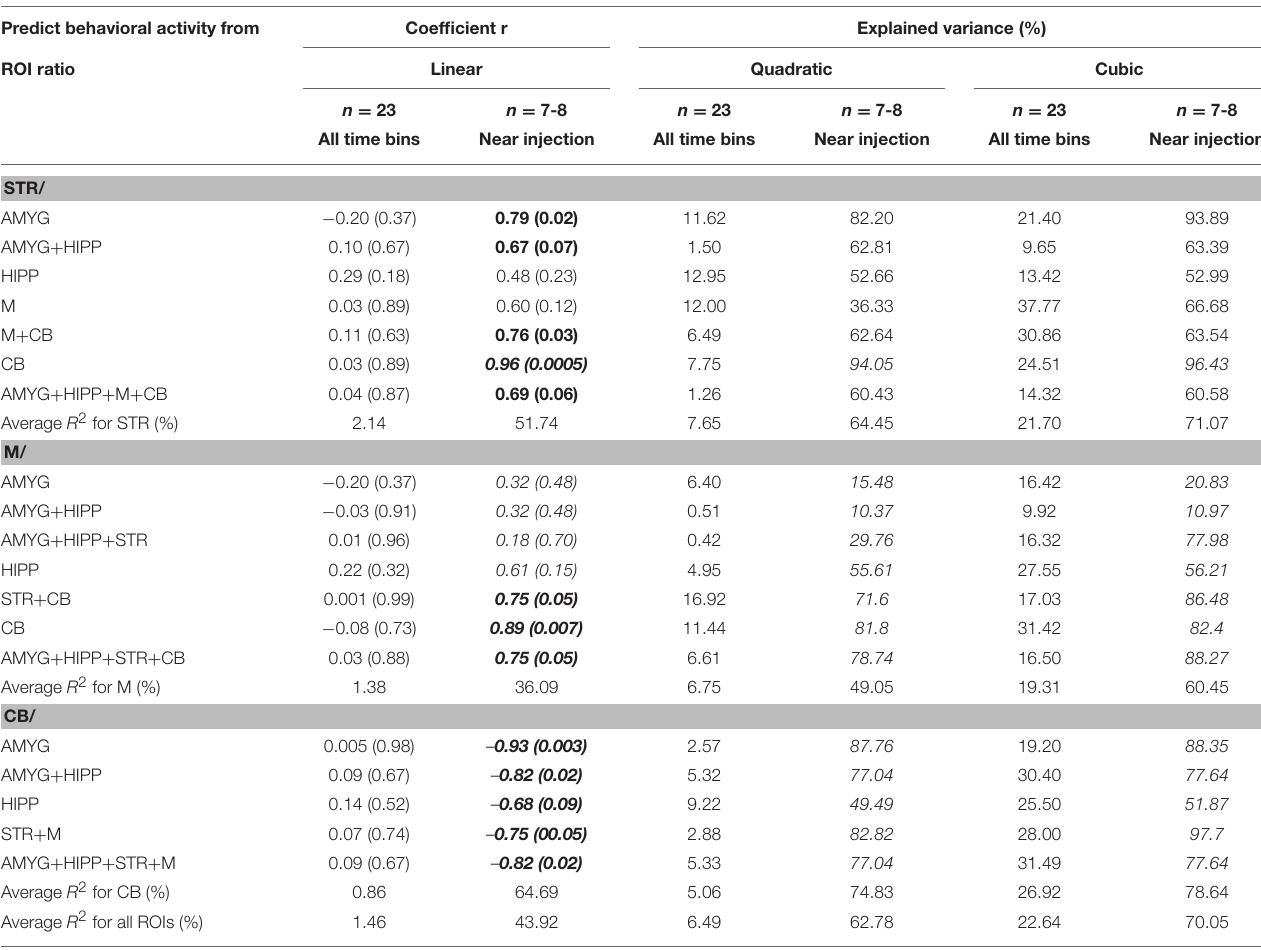
TABLE 3 | Changes in uptake in ROI relative to a reference region correlated with changes in behavioral activity across scan 1. Predict behavioral activity from Coefficient r Explained variance (%) ROI ratio Linear Quadratic